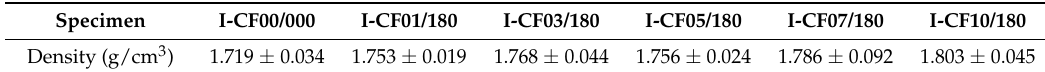
Table 2. Density of oxy-fluorinated carbon fibers.